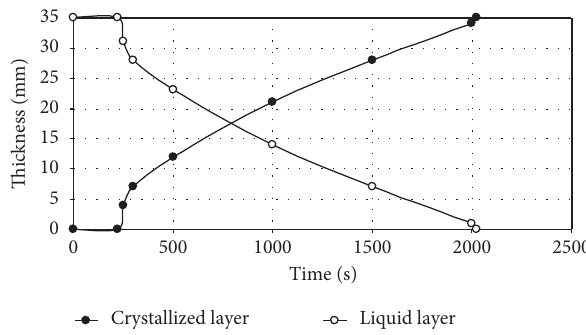
Figure 4: Comparative dynamics of changes in the thickness of the crystallized and liquid layers of the cast part in the crystallization